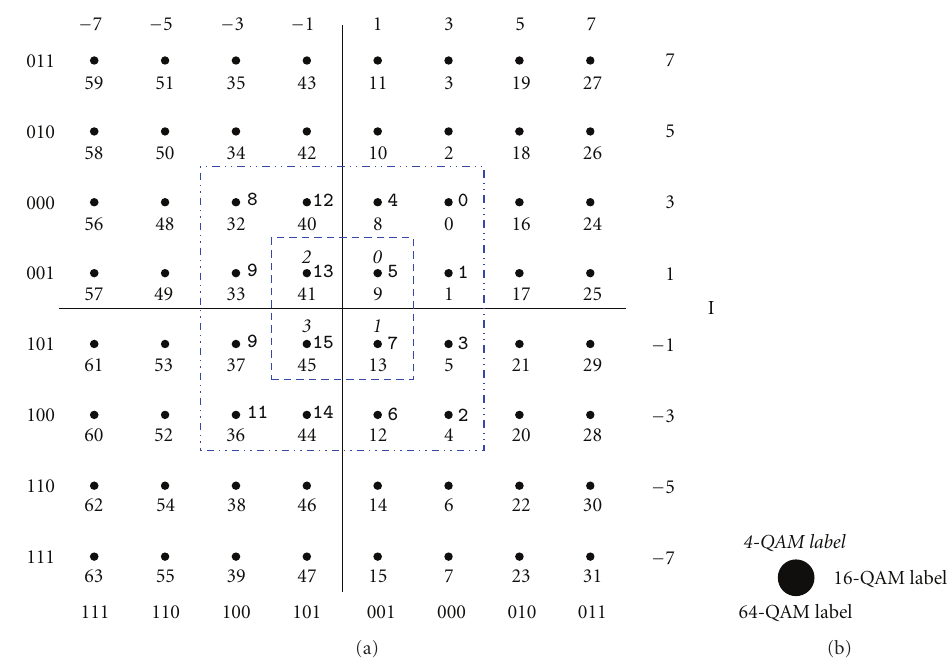
Figure 4: Grey-coded 64-QAM constellation used in the mapper module. (a) The 4-QAM and 16-QAM constellations are delimited with a dashed lines; (b) label guide for identifying the constellation point